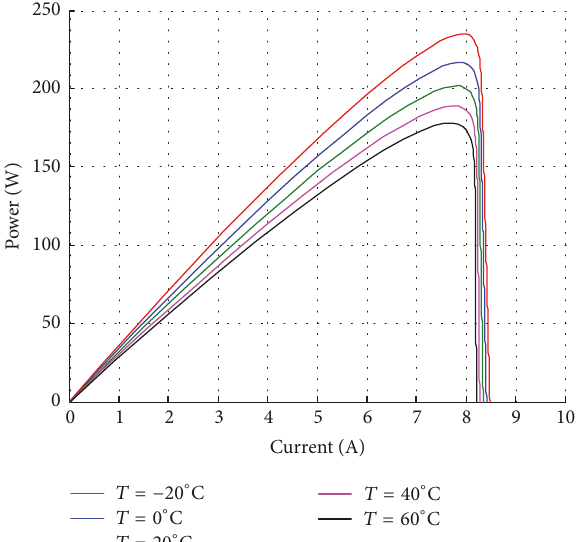
Figure 10: 𝑃 - 𝐼 curves for different cell temperatures.